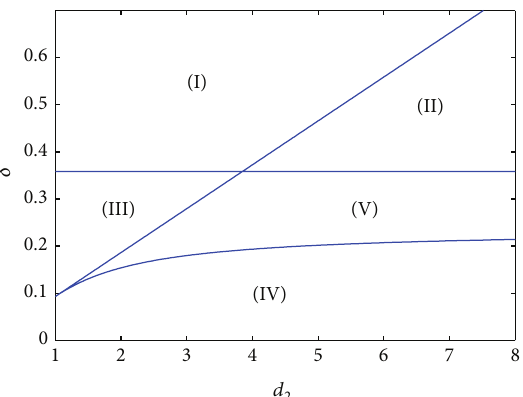
Figure 1: Bifurcation diagrams of system (3) with respect to 𝑑 2 and 𝛿 when 𝛼 = 0.4 , 𝛽 = 5/6 , and 𝑑 1 = 1 . Hopf bifurcation line: 𝛿 = 0.3587 ; Turing bifurcation line: 𝛿 = 0.0932𝑑 (375/1369) . Hopf-Turing bifurcation point: (4.0611, 0.3587) . Turing-wave bifurcation point: (1,0.0932)